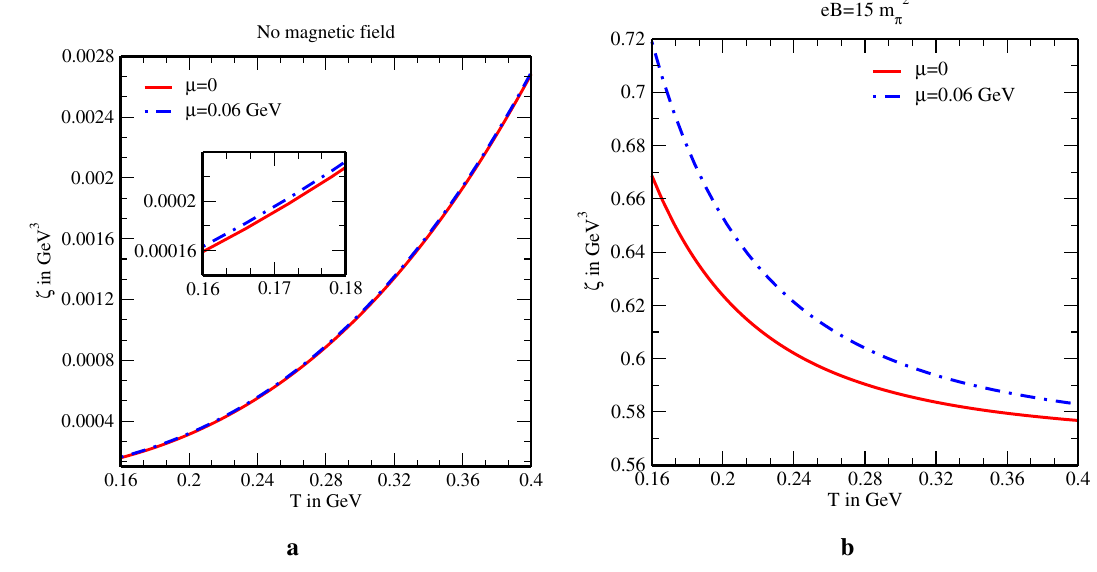
Fig. 4 Variations of the bulk viscosity with temperature in the a absence and b presence of strong magnetic